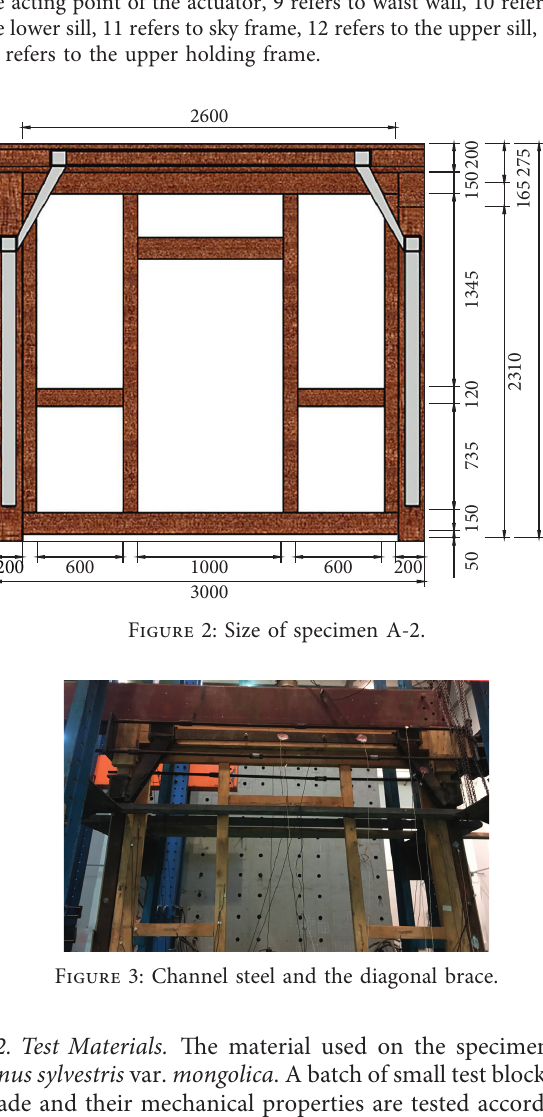
ment of the bottom of the column shall be measured at the measuring point ➄ , respectively, and the vertical and hor- izontal displacement of the bottom of the right column shall be measured at the measuring point ➅ , respectively. The strains at the left end of the beam are measured at the measuring point ➆ and the strains at the right end of the beam are measured at the measuring point ➇ .